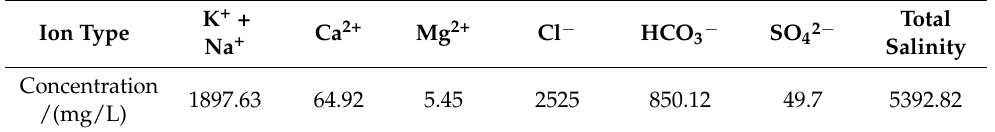
Table 1. Ion composition of the formation